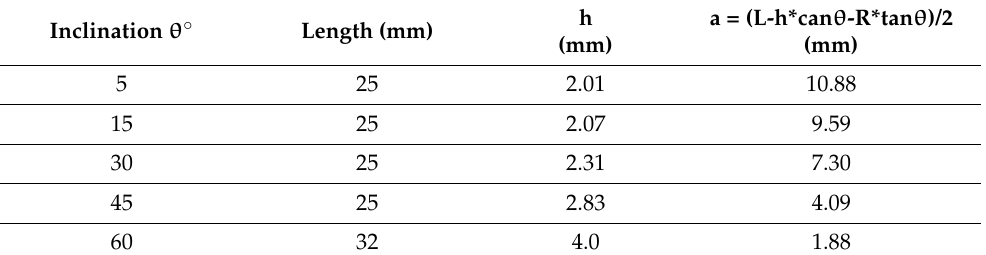
Figure 1. The SCSs of PP. Table 2. Geometric parameters of SCS.